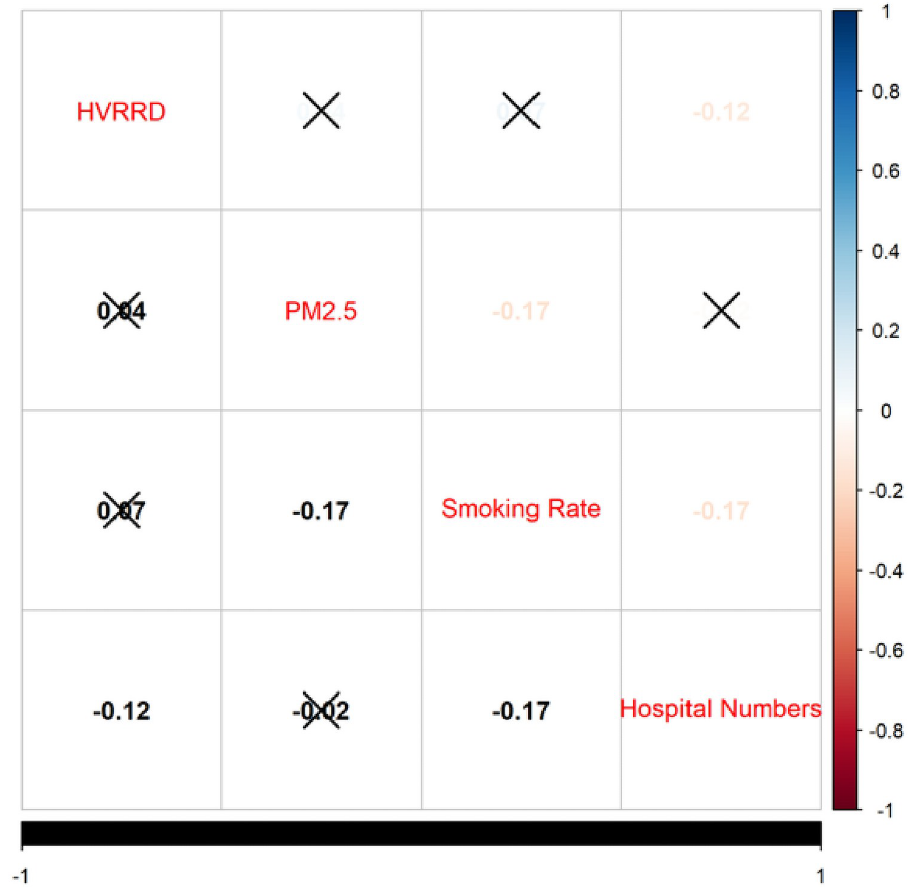
Fig 2. Results of Pearson correlation test for all four variables. HVRRD refers to the hospital visit rate for respiratory diseases. The symbol X indicates that the two variables’ correlation coefficient is not significant with a p- value greater than